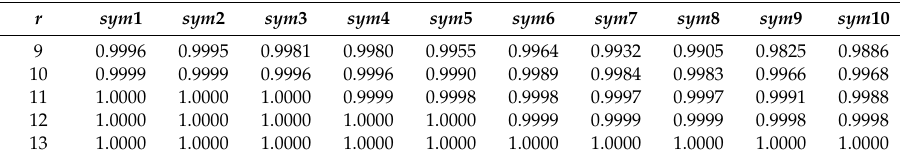
Table 22. Experimental results ( SSIM ) of 3D tomographic 12-bit image “Trufi_COR” DWT by using bit-width r of symlets filters coe ffi cients.